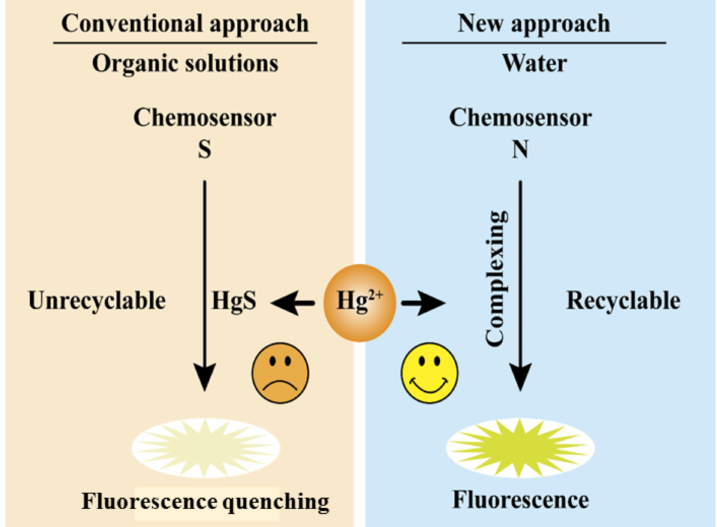
Figure 3. Common approaches using thio- and nitrogen-based ligands as chemosensors for Hg 2+ detection. The mechanism of detection is mainly through metal complex